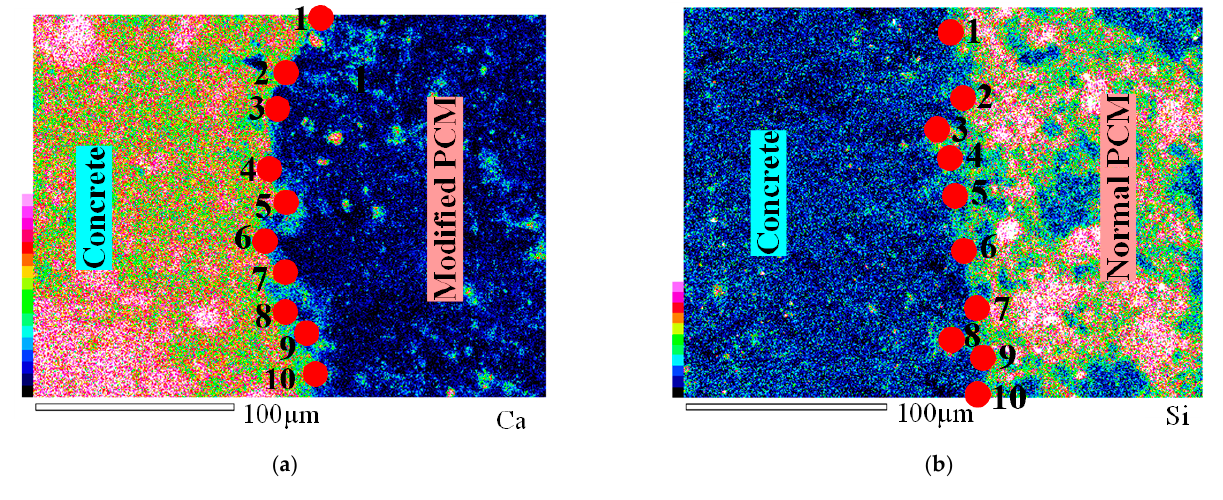
Figure 4. Element distribution using EDS over a selected area at 500 magnification level (X500). ( a ) Modified 5% silica PCM, ( b ) normal PCM.